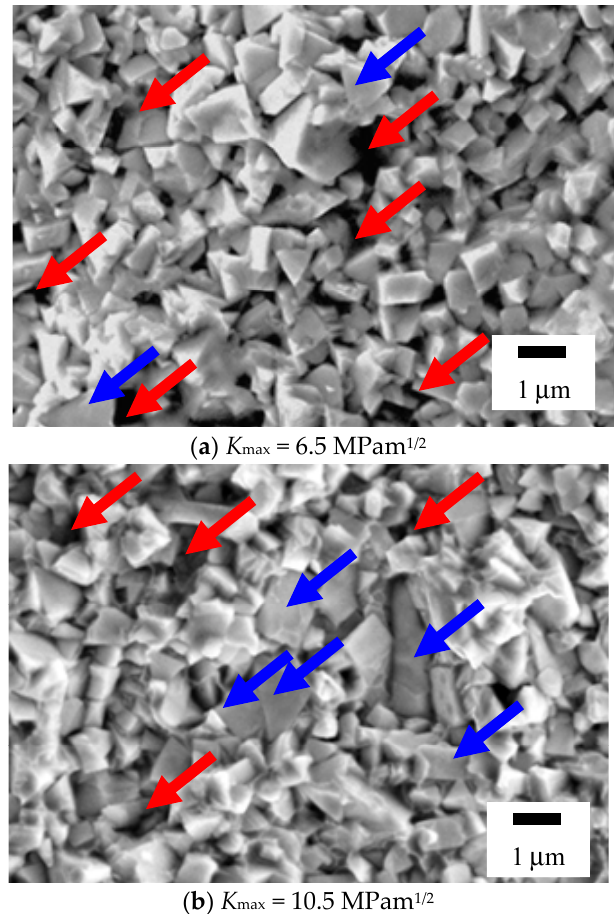
Figure 11. SEM images of the fracture surface on the un-notched specimen failed at σ a of 1600 MPa. Red arrows show missing portions of WC grains. Blue arrows show cleavage fractures of WC grains; ( a ) Image taken near the crack origin (at the low K max ); ( b ) Image taken far from the crack origin (at the high K max ).